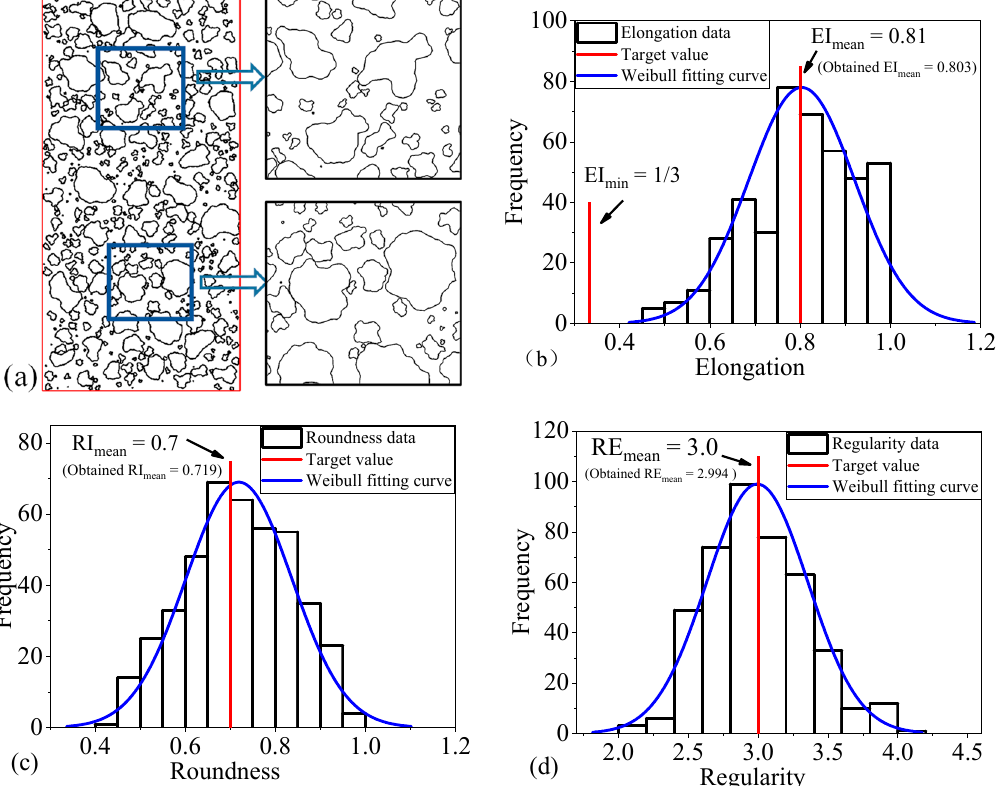
Figure 12. Granular mixture with predetermined coarse particle shape features: ( a ) Sample of generated granular mixture, ( b ) elongation distributions of coarse particles, ( c ) roundness distributions of coarse particles, and ( d ) regularity distributions of coarse particles.